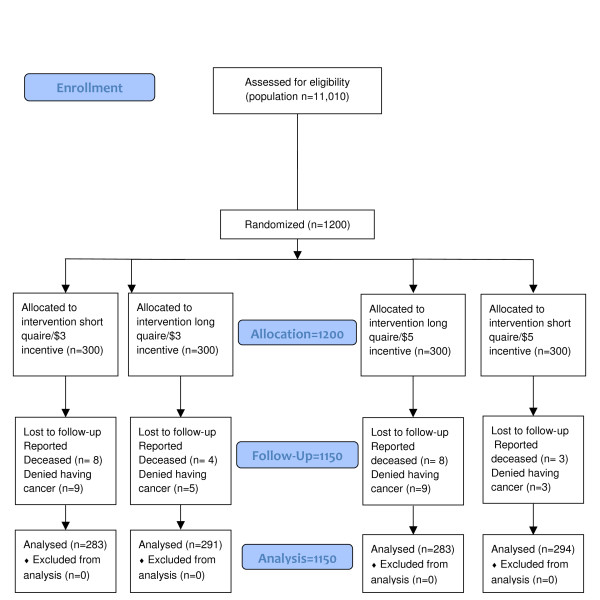
Consort Flow DiagramTables.